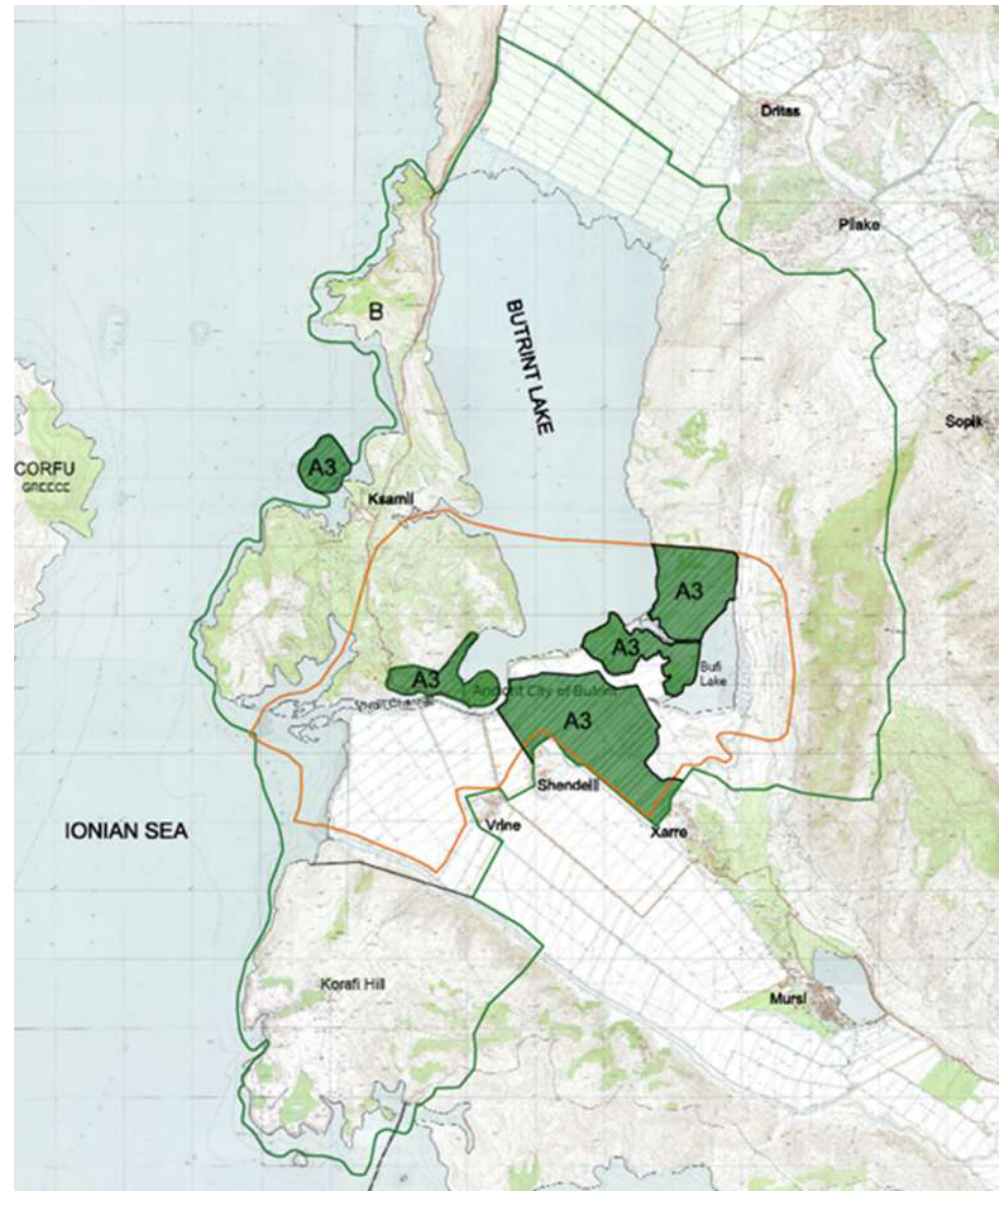
Figure 3: Current protected area